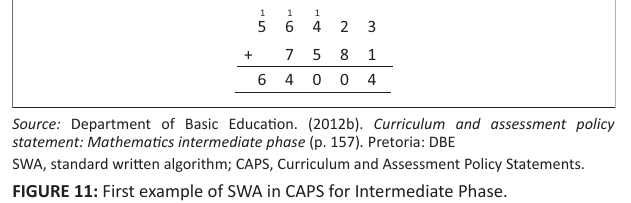
FIGURE 11: First example of SWA in CAPS for Intermediate Phase.